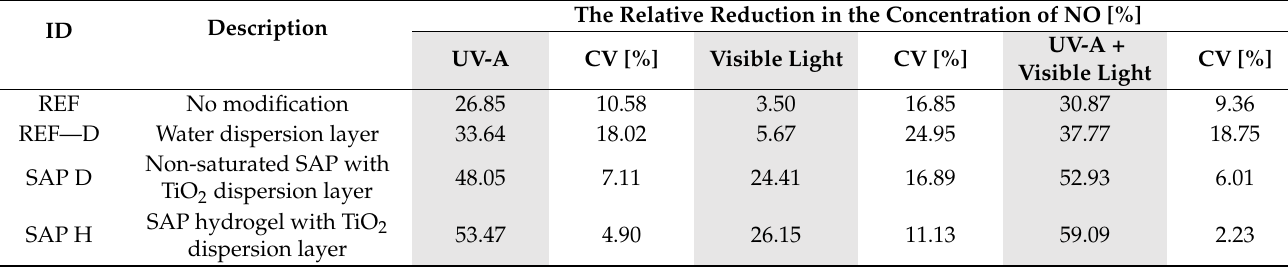
Table 4. Relative reductions in NO concentrations in performed tests for all considered surface modification techniques.